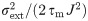
Scaling synaptic strengths as J ∝ 1/K can preserve correlations in networks with widely different firing rates.Results of simulations of a LIF network consisting of one excitatory and one inhibitory population (Table 2). Average cross-covariances are determined with a resolution of 0.1 ms and are shown for excitatory-inhibitory neuron pairs. Each network receives a balanced Poisson drive with excitatory and inhibitory rates both given by σext2/(2τmJ2), where σext2 is chosen to maintain the working point of the full-scale network. The synaptic strengths for the external drive are 0.1 mV and −0.1 mV for excitatory and inhibitory synapses, respectively. A DC drive with strength μ
ext is similarly adjusted to maintain the full-scale working point. All networks are simulated for 100 s. For each population, cross-covariances are computed as averages over all neuron pairs across two disjoint groups of 𝓝 × 1000 neurons, where 𝓝 is the scaling factor for the number of neurons (a given pair has one neuron in each group). Autocovariances are computed as averages over 100 neurons in each population. A, B Reducing in-degrees K to 50% while the number of neurons N is held constant, J ∝ 1/K closely preserves both the size and the shape of the covariances, while J∝1/K diminishes their size. C, D Reducing both N and K to 50%, covariance sizes scale with 1/N for J ∝ 1/K but with a different factor for J∝1/K. Dashed curves represent theoretical predictions. The insets show mean autocovariances for time lags Δ ∈ (−30, 30) ms.